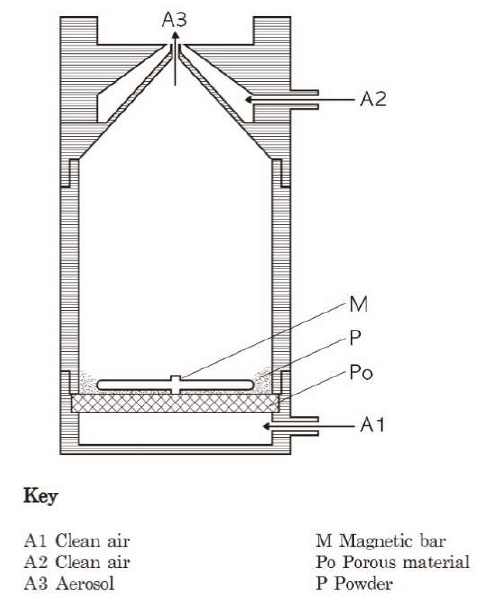
Figure 1. CNF generator. CNF generation scheme. Clean air was introduced into A1 and A2, while CNF powder (P) was stirred using magnetic bar (M). CNF aerosols generated by fluidized bed (A3) were then delivered into inhalation chamber.